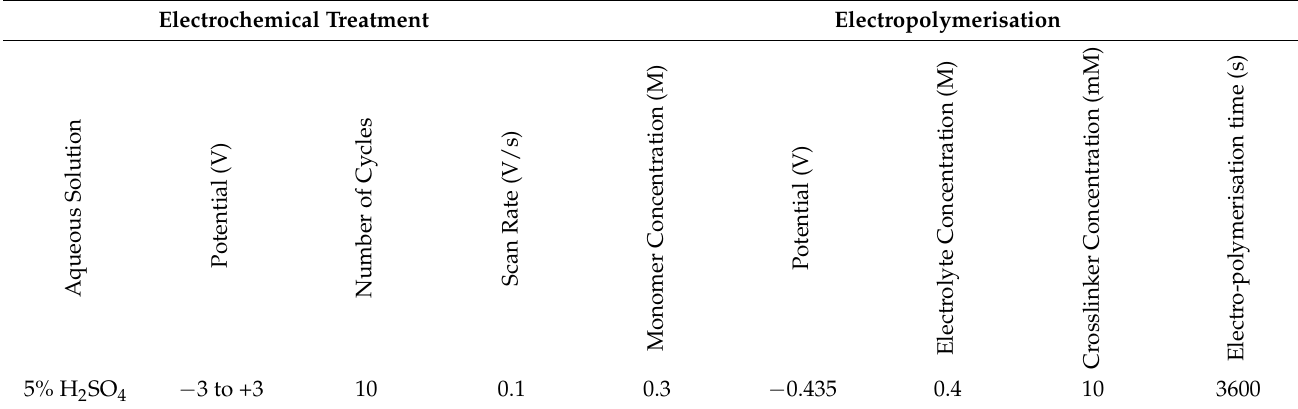
Table 2. Parameters and conditions for CFs electrochemical treatment and electropolymerisation. Electrochemical